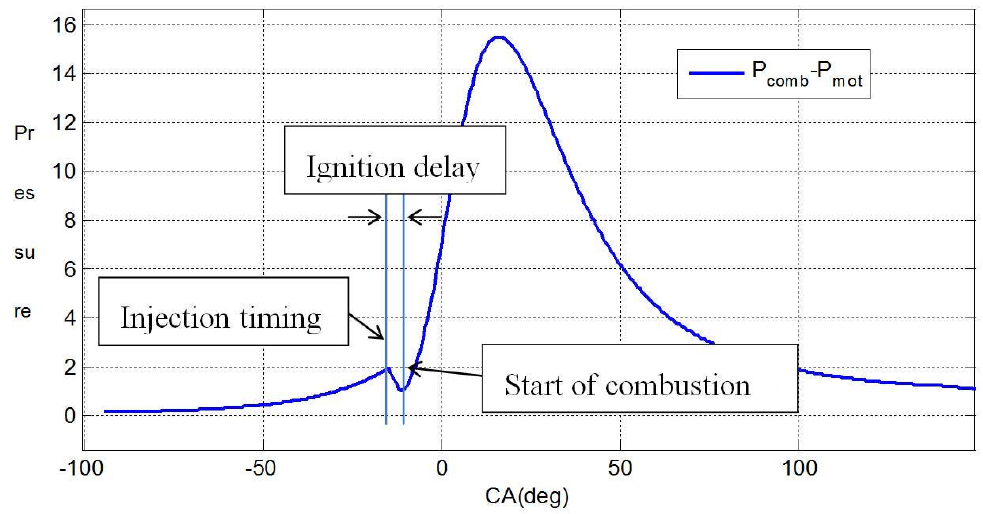
Figure 7. Ignition delay demonstrated by pressure difference trace (measured from a medium-duty diesel engine).